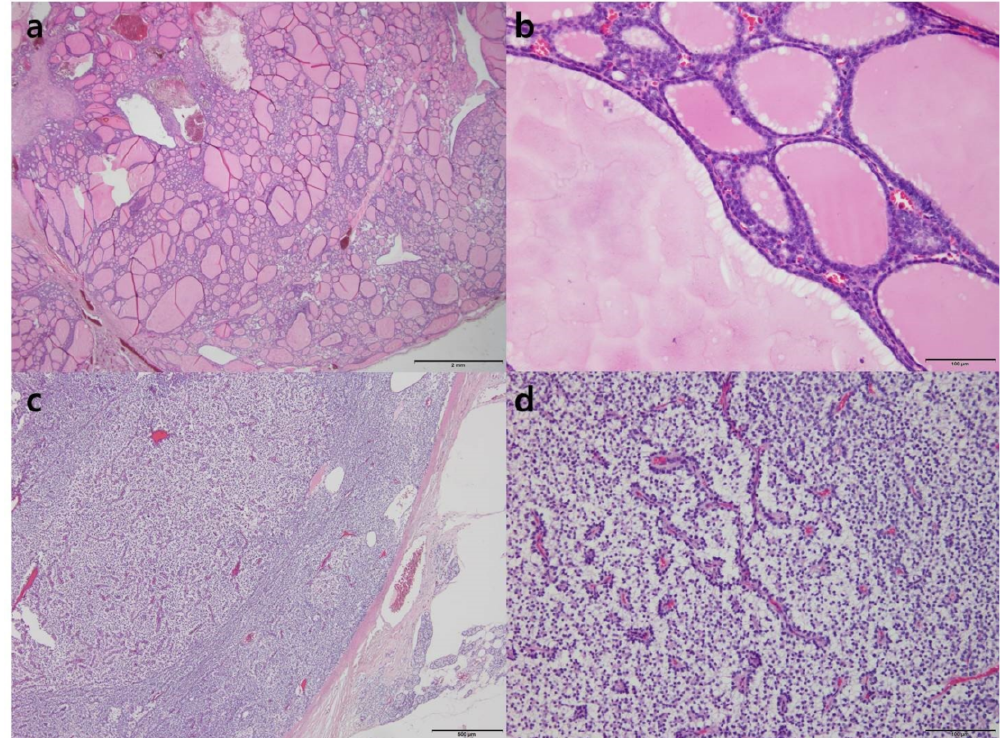
Figure 3. Pathologic sections of nodular hyperplasia of the thyroid gland ( a , b ) and parathyroid adenoma ( c , d ) with hematoxylin and eosin staining. Low-power ( a , × 10) and high-power ( b , × 200) microscopic views of the lesion show variably sized dilated follicles. The parathyroid adenoma ( c , × 40, d , × 200) is composed mainly of chief